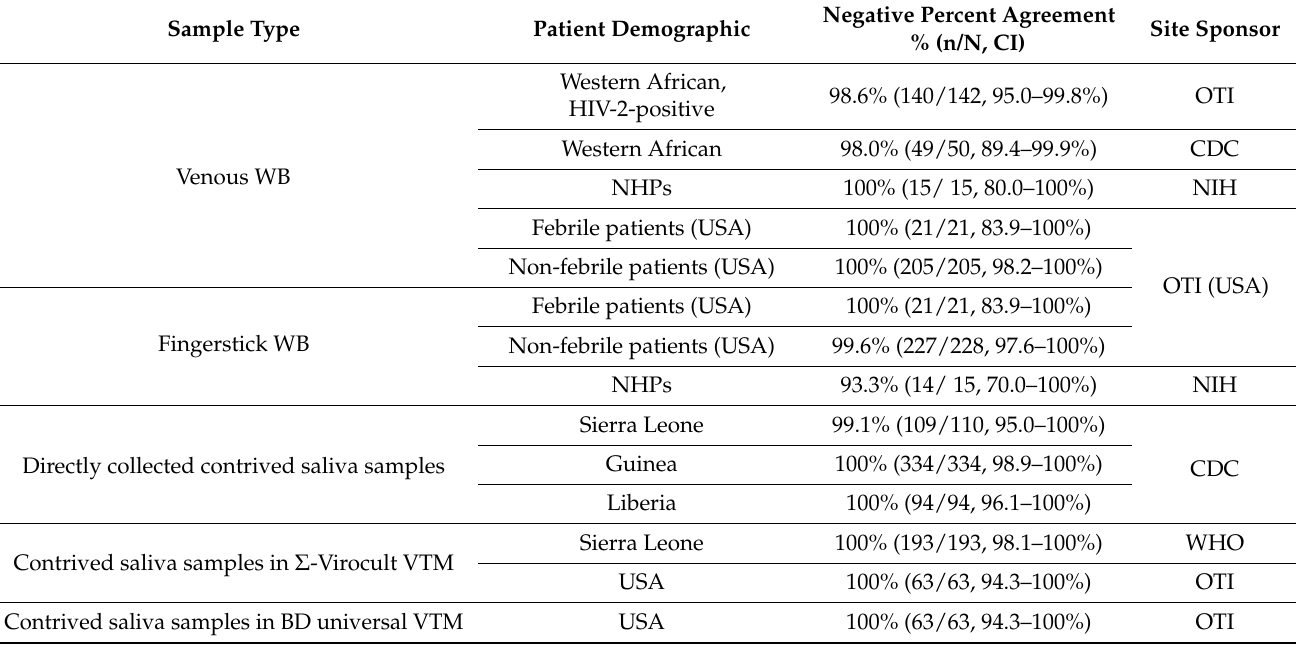
Table 1. Specificity performance of OraQuick ® Ebola Rapid Antigen Test in different sample types and matrices.